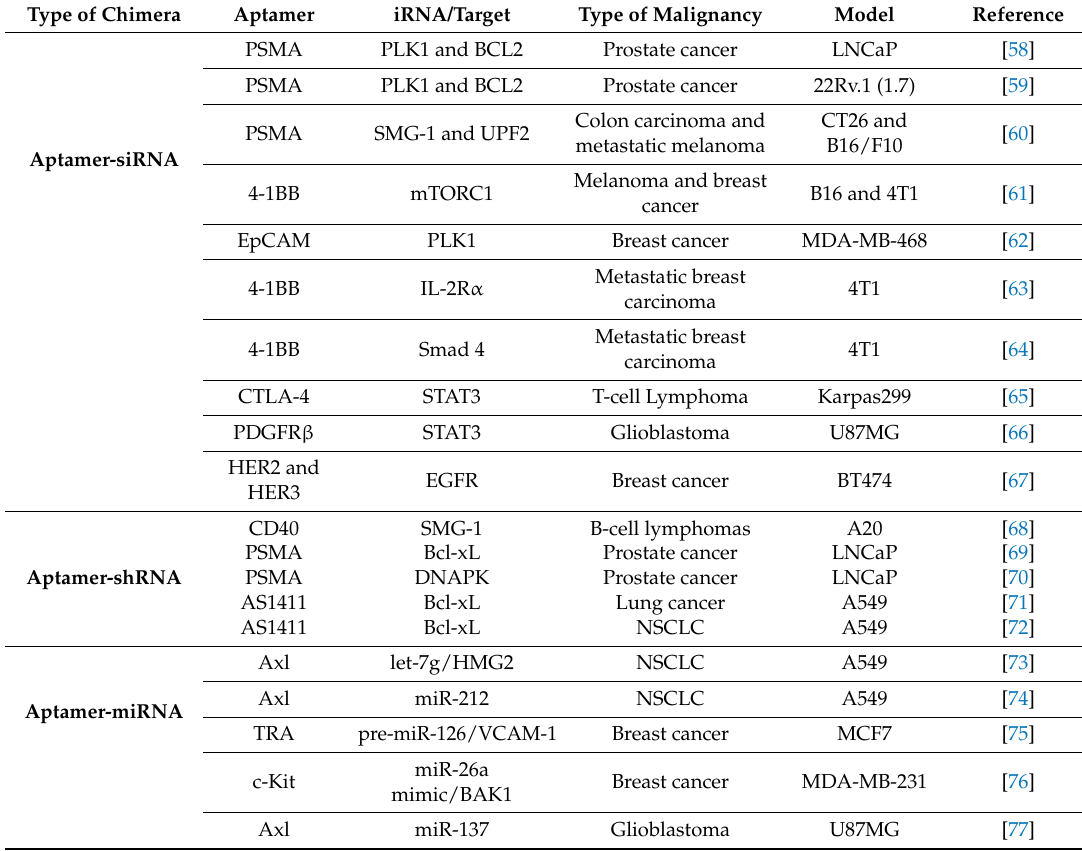
Table 1. Summary of aptamer-based targeted delivery of interfering RNAs for cancer treatment. NSCLC = Non-small cell lung